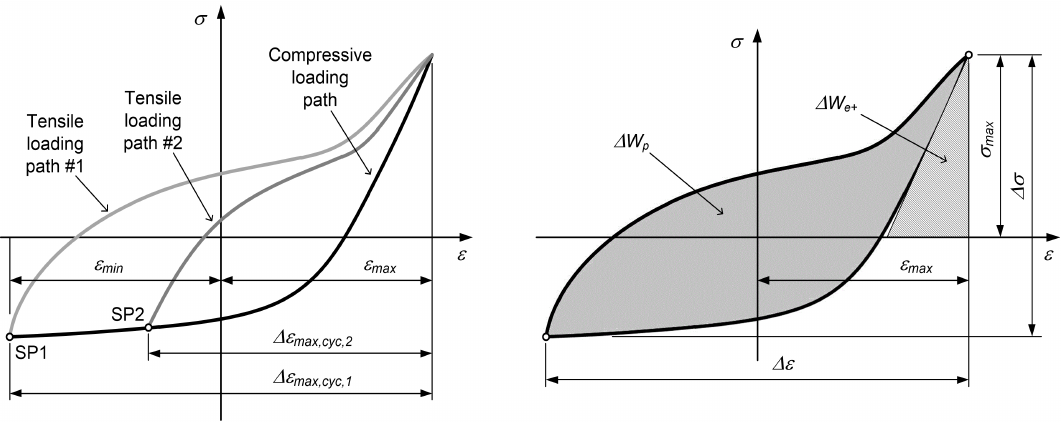
Figure 2. Closed hysteresis loops of magnesium alloy for different strain ranges of low-cycle fatigue tests (left) and energy related to closed hysteresis loops